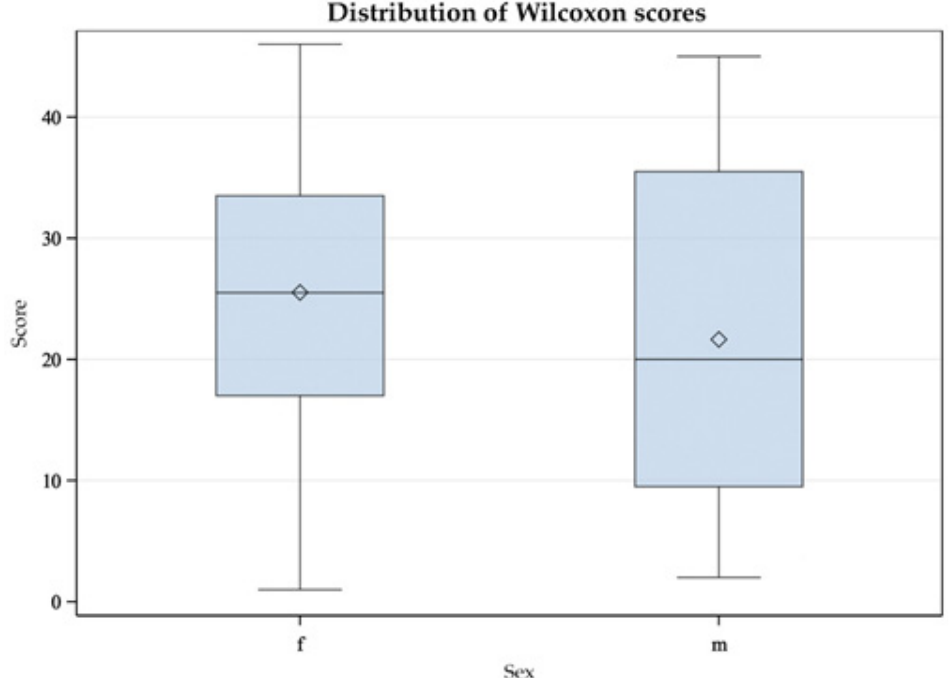
Figure 6. Mann-Whitney U test with double sided t-approximation plotting the differences between female (f) and male (m) Greater Flamingos ( Phoenicopterus roseus ) in their CORTf